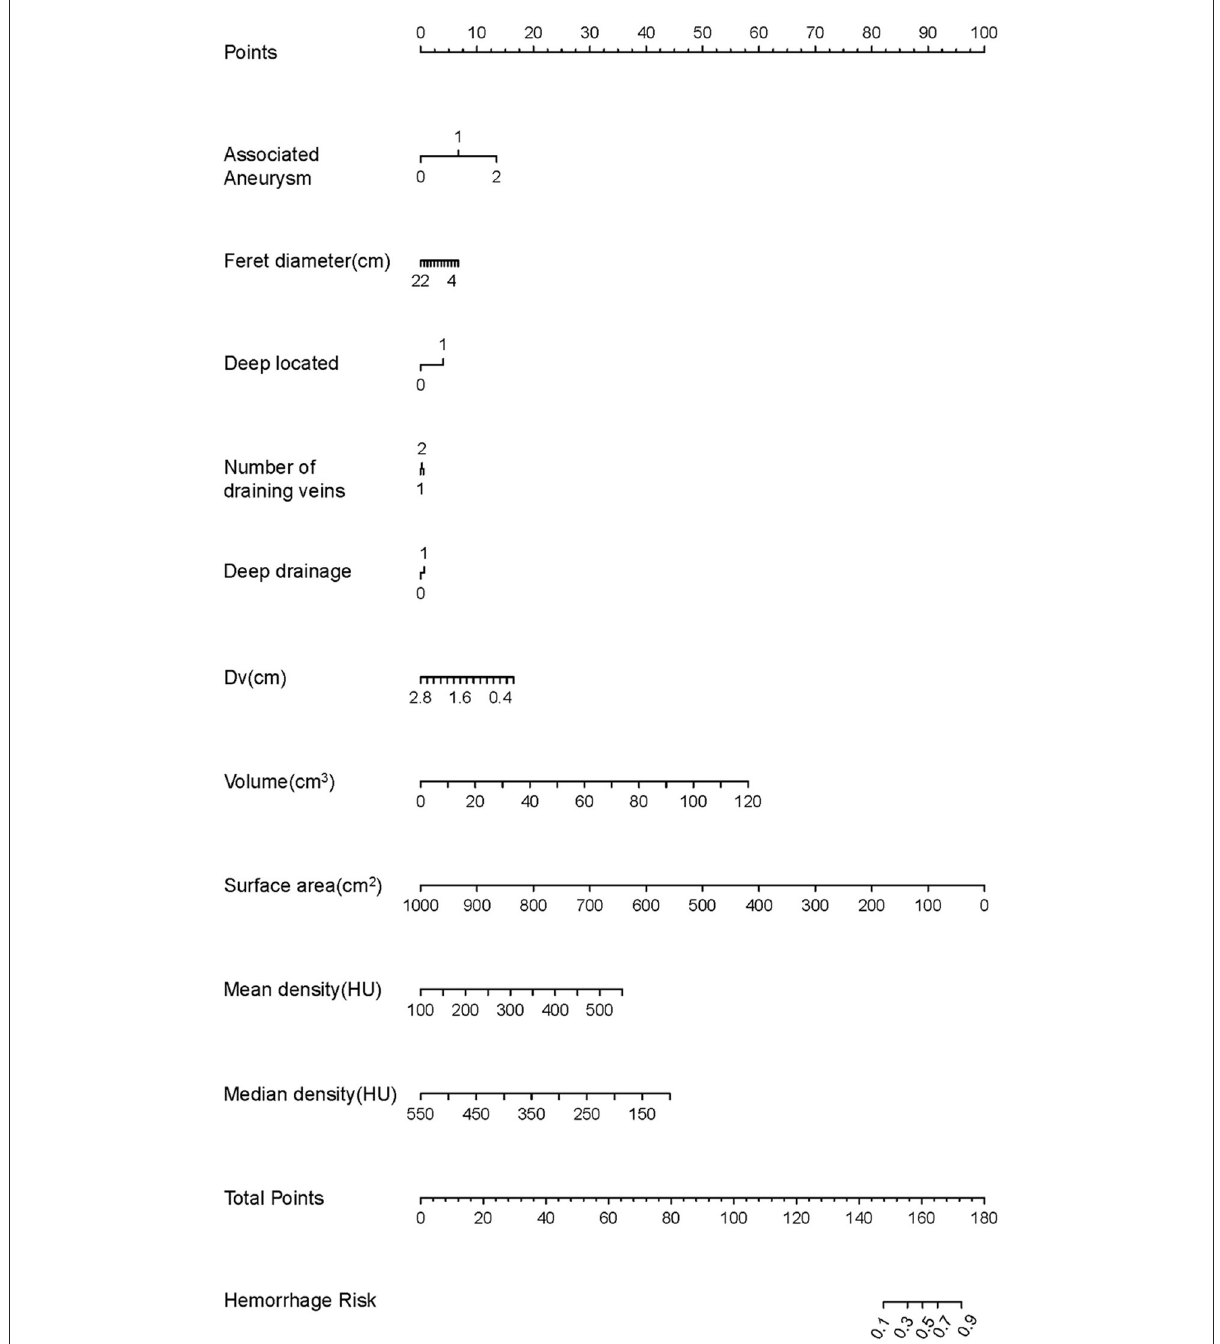
FIGURE2 The development of the nomogram. The features are ranked by the standard deviation of the β x’s. Every factor can match a score using the nomogram. The total score can correspond to the predicted value of the hemorrhage risk on a scale.